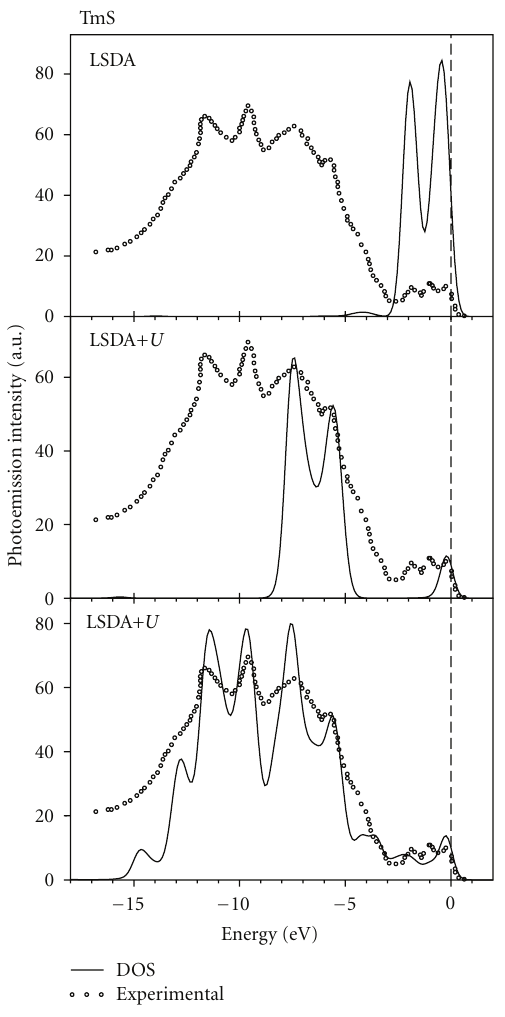
Figure 62: Comparison of the calculated 4 f DOS in LSDA and LSDA+ U approximations [384] with the experimental UPS spectra from [373]. The bottom panel shows the LSDA+ U 4 f DOS taking into account the multiplet structure of the 4 f 11 final state (see explanations in the